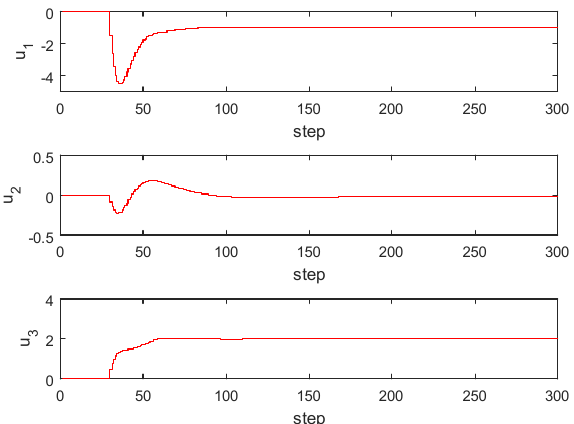
Figure 15. GPC with reduced internal model closed loop simulation of 300 time-steps, trend for MVs signals (u 1 , u 2 and u 3 ). Controller parameters: control horizon N u = 20, prediction horizon N = 400, and the R matrix = identity matrix